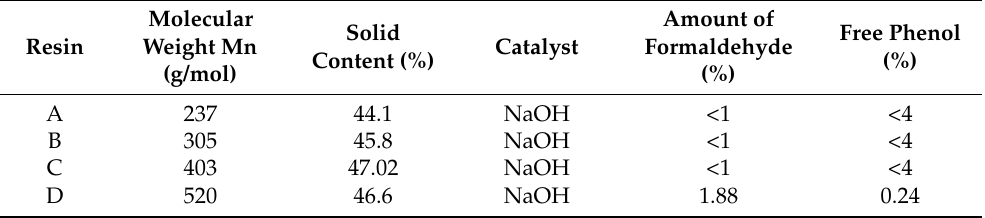
Table 1. Properties of the PF resins used for beech wood modification.